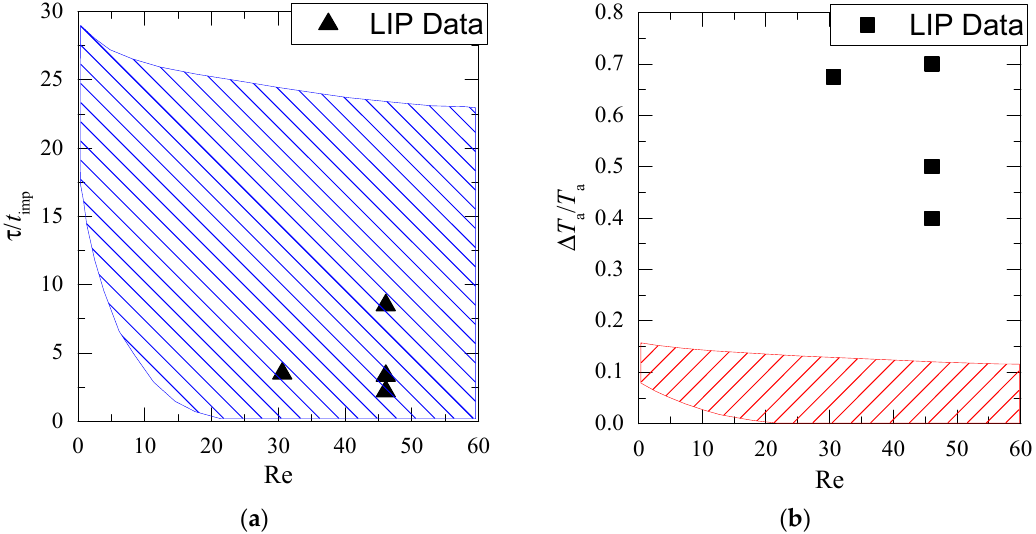
Figure 11. Dimensionless lifetime ( τ / t imp ) of the low gas temperature and relative temperature drop ( Δ T a / T a ) in the trace of droplets versus Re number (crosshatched area shows the data from the work in [21]): ( a ) dependence of τ / t imp = f (Re); ( b ) dependence of Δ T a / T a = f (Re).